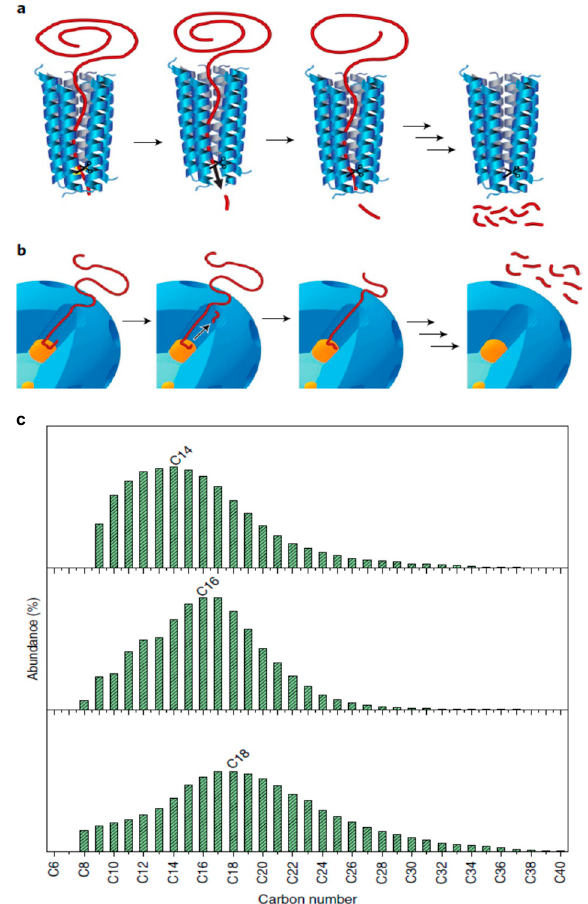
Figure 4. Processive deconstruction of macromolecules. ( a ) The processive mechanism through which many enzymes deconstruct large macromolecules. First, the polymer threads and binds into the catalytic pore or cleft. A catalytic cleavage reaction at the active site (represented by a pair of scissors) releases a low-molecular-mass fragment. The macromolecule then threads further into